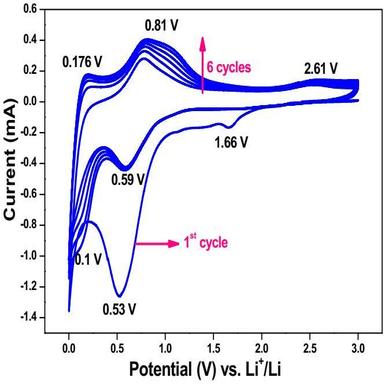
Cyclic voltammograms of IL-β-MNV at a scan rate of 0.5 mVs-1.